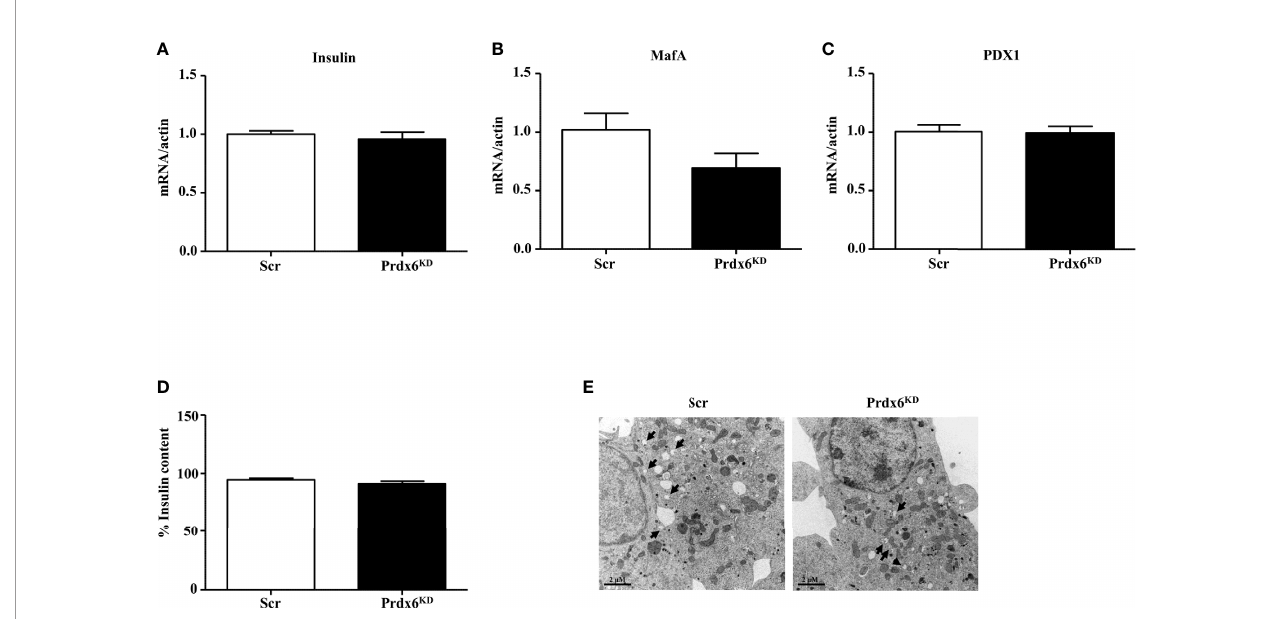
FIGURE 2 | Evaluation of insulin transcription and synthesis and ultrastructural analysis of insulin granules. (A – C) Gene expression of Insulin, MafA, and PDX1, respectively. (D) Insulin content was assessed in Scr (white bar) and Prdx6 KD cells (black bar) by using insulin intracellular staining followed by FACS analysis. (E) Transmission electron images assessing granule localization in Scr and Prdx6 KD . Original magni fi cation: ×12,000. Values are expressed as mean ± SEM (n =